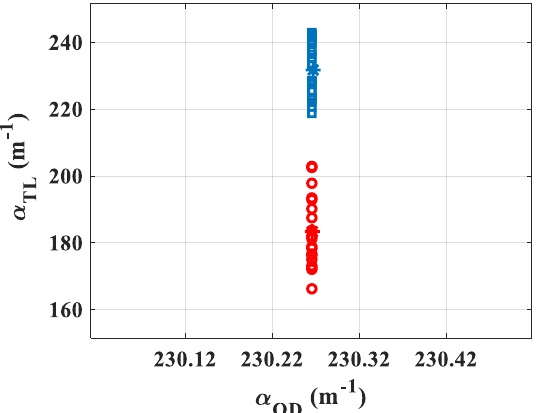
Figure 6. Graphical representation of the absorption values measured by the TL system for OD1 nanoparticles suspensions. The central values (stars) represent the average obtained on 𝛼 𝑇𝐿 ; blue squares: 5 nm, red circles: 50 nm.